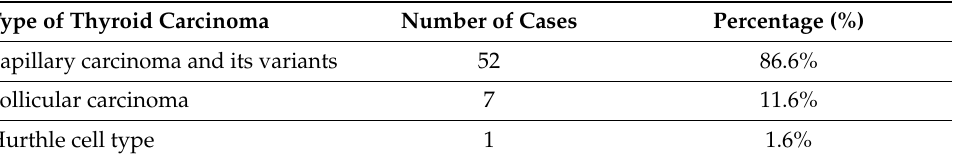
Table 1. Full details of the study cohort for participants, including types and percentage of thyroid